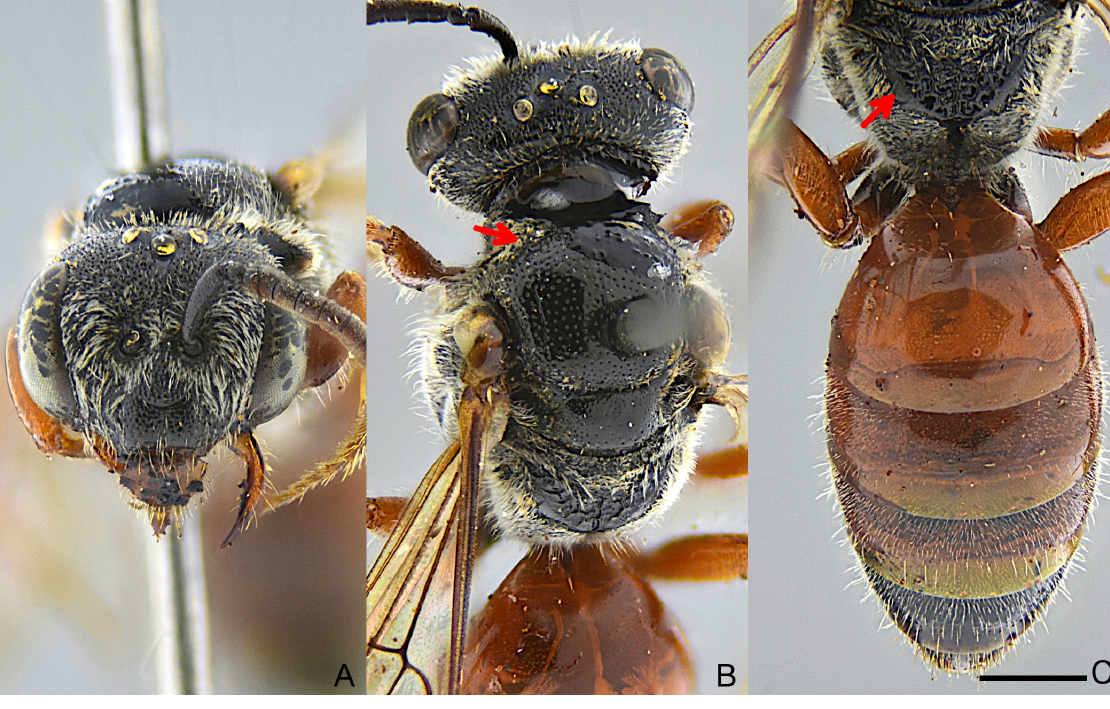
Fig. 2 . Austrosphecodes balrog sp. nov., holotype ♀ (DZUP 568513). A . Head. B . Mesosoma, red arrow: crowded punctures on anterior margin of mesoscutum. C . Propodeum and metasoma, red arrow: metapostnotum triangular. Scale bar = 1